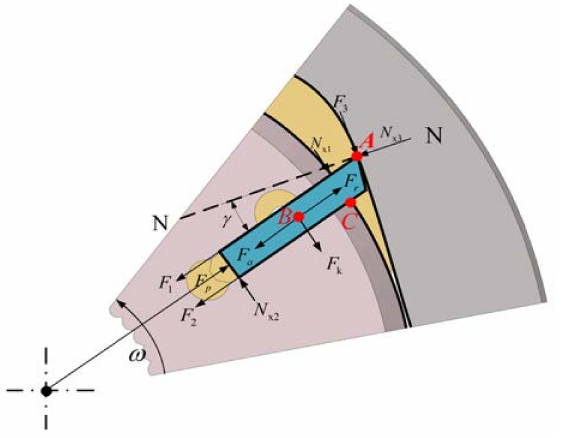
Figure 3. Force analysis of vanes in the oil suction